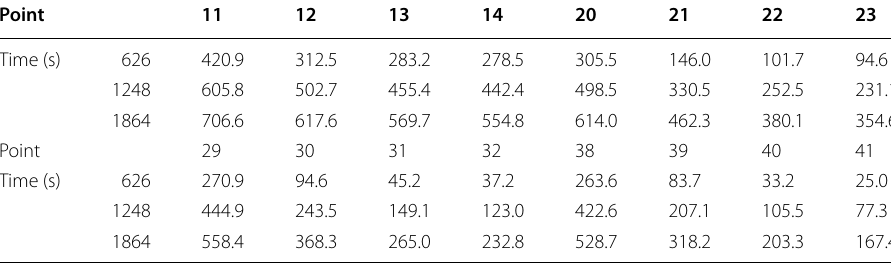
Table 5 Fire scenario 1: temperature at various sections of the beam Point 11 Time (s) 626